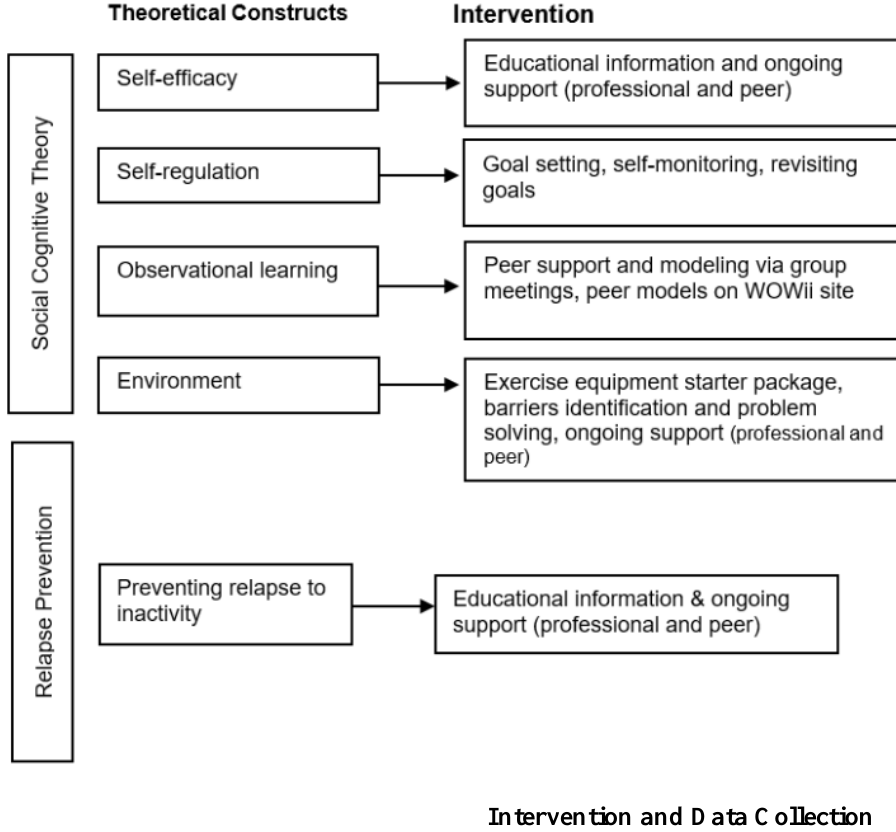
Figure 1. Theoretical constructs and key components of the Workout on Wheels internet intervention (WOW ii )